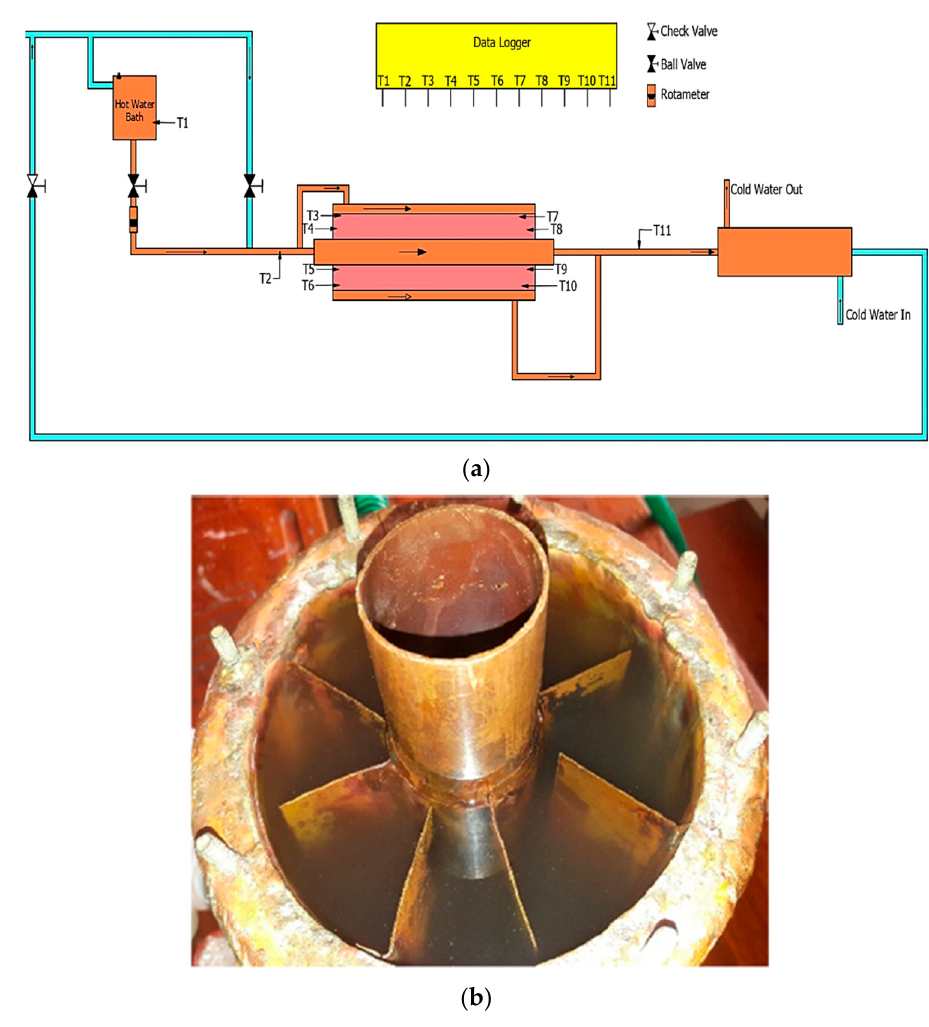
Figure 1. ( a ) Schematic of LHTES setup. ( b ) Schematic of fin arrangement. Table 3. Probe location.